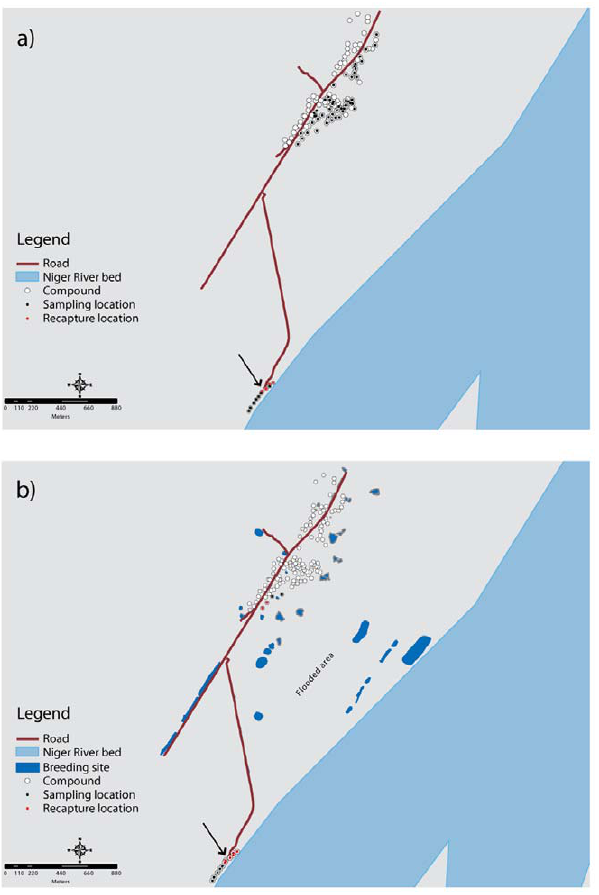
Figure 1. Sampling and recapture locations in Fourda and Kenieroba with breeding sites. Maps show Fourda (to the South) and Kenieroba (North) in March (a) and July (b). The arrow indicates the marked mosquito release site. Note that the compounds in the northern half of Fourda had much higher numbers of mosquitoes overall, which correlated with higher numbers of recaptures (results not shown). See text for details on sampling regime.